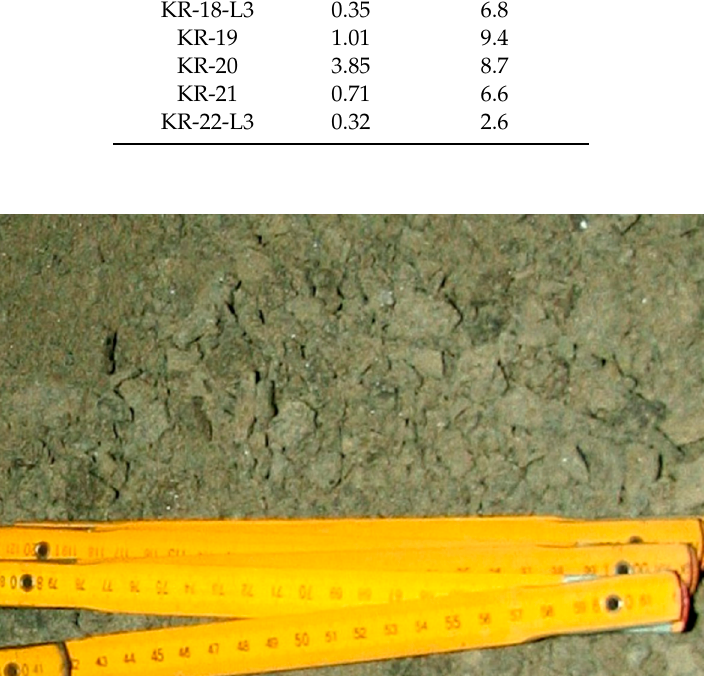
Figure 5. Outburst material from the Rudna mine [38].